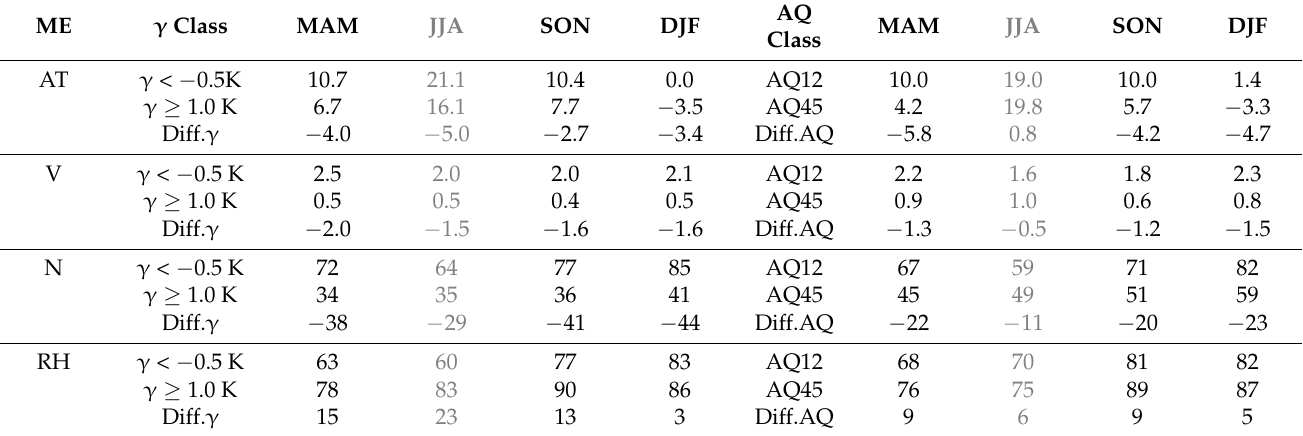
Table 4. Average values of meteorological elements separately for various γ classes and AQ